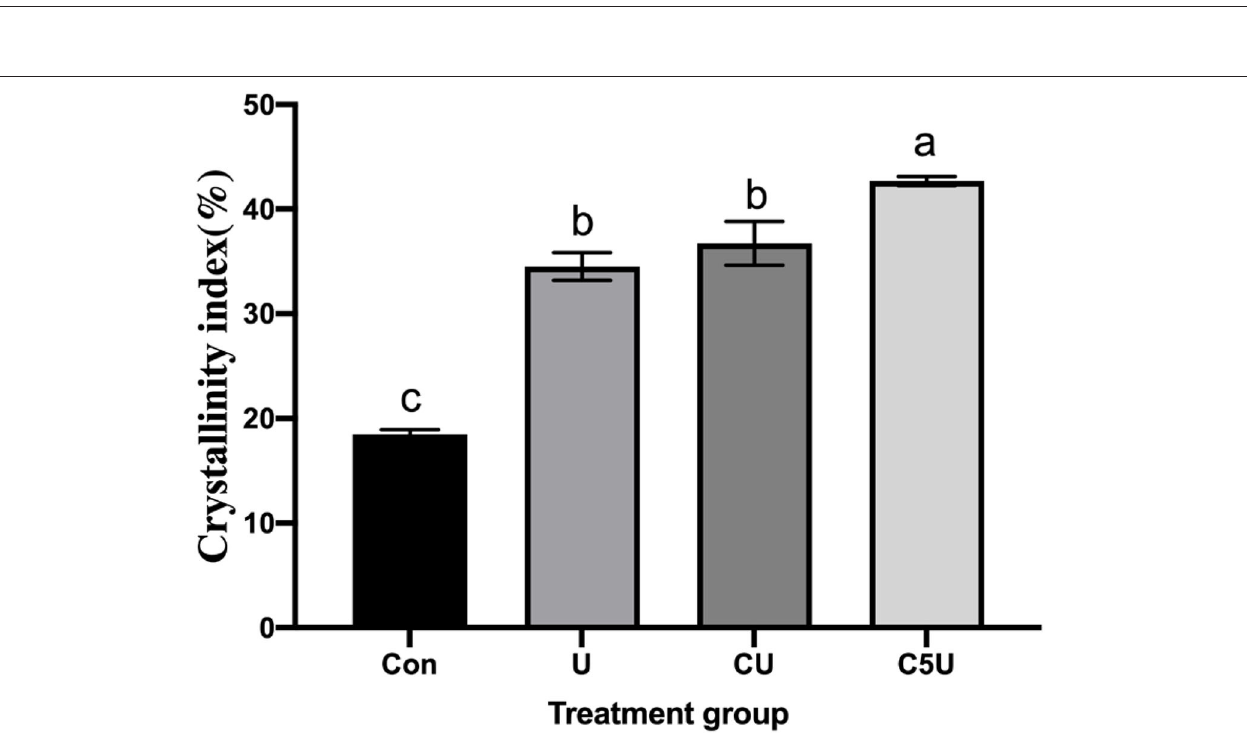
FIGURE 3 | Effect of CSL and urea pre-treatment on the cellulose crystalline index (CrI, %) of RS. Con, without additive control; U, 5% urea; CU, 9% CSL + 2.5% urea; C5U, 9% CSL + 5% urea. Different superscript letters a, b, c, and d indicate significantly different values ( P < 0.05) in different groups, and the same or no letters indicate insignificant differences ( P >